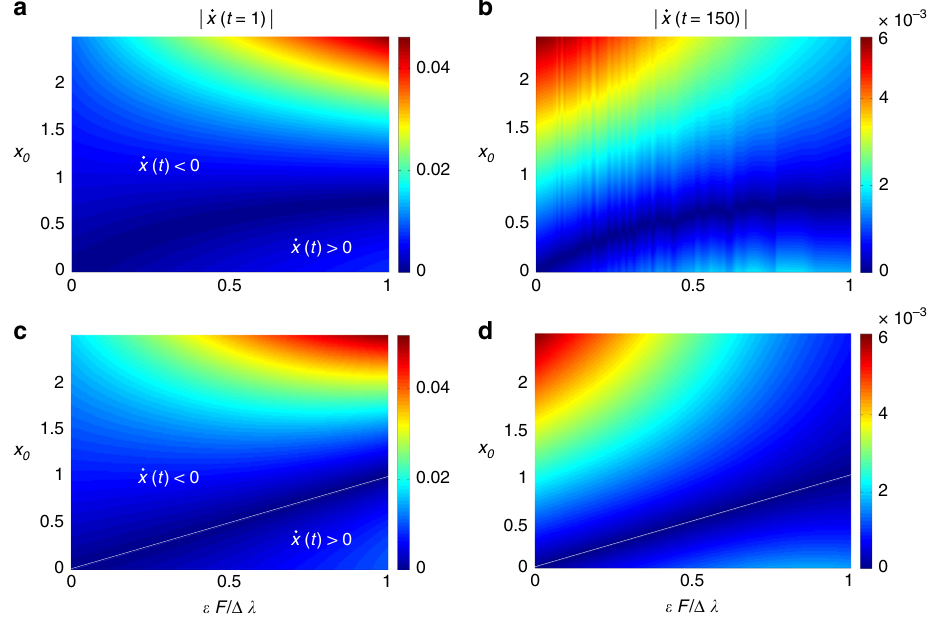
Fig. 2 Comparison between the numerical and analytical calculations of the population fl ux. Population fl ux _ x ð t Þ (in absolute value, for clarity) as a function of the normalised connection strength ϵ F = Δ λ and the initial population distribution x 0 for two connected networks out of equilibrium. a , b Numerical calculation of _ x ð t Þ for two scale-free networks of N ¼ 250 nodes (see caption of Fig. 1 for details), for t ¼ 1 ( a ) and t ¼ 150 ( b ). c , d Analytical approximation to _ x ð t Þ for the same situations. These plots show that Eq. (9) is in quantitative agreement with the numerical results, despite only depending on the fi rst eigenvalues of networks A and B , and the centrality of the connector nodes. In the numerical simulations ( a – b ), the connection strength ϵ F has been modi fi ed by both changing the connector links (i.e., F ) and the weight of the connector links (i.e., ϵ ). This way, we have gradually swept ϵ F = Δ λ from 0 to